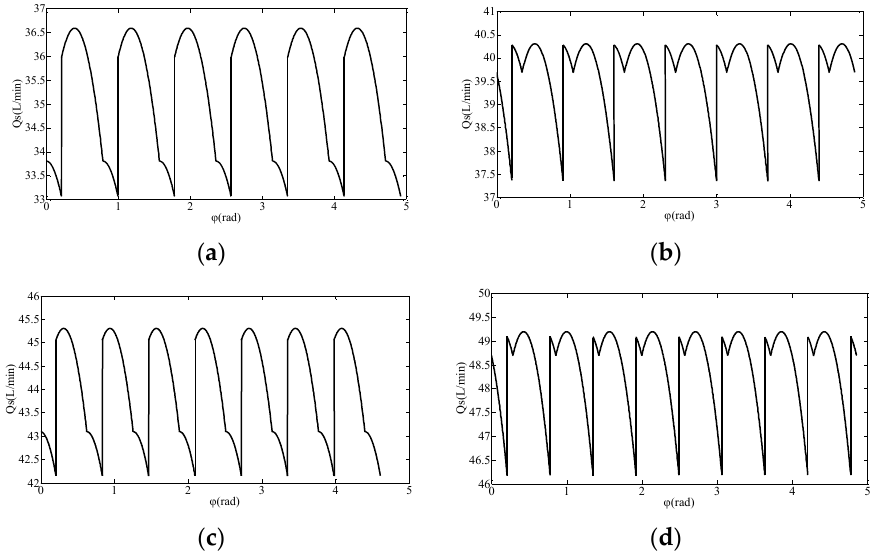
Figure 6. Actual output flow rate of piston pumps with 8~11 pistons for Δφ /2 = φ 0 = 6°. ( a ) output flow of 8-plunger pump; ( b ) output flow of 9-plunger pump; ( c ) output flow of 10-plunger pump; ( d ) output flow of 11-plunger pump.